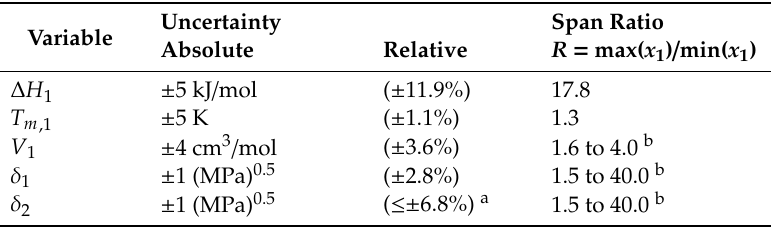
Table 5. Influence of variable uncertainty on molar solubility x 1 of l -ascorbic acid at 25 ◦ C. Uncertainty Span Ratio Variable Absolute Relative R = max( x 1 ) / min( x 1 ) ∆ H ± 5 kJ / mol ( ± 11.9%) 17.8 1 T m ,1 ± 5 K ( ± 1.1%) 1.3 V 1 ± 4 cm 3 / mol ( ± 3.6%) 1.6 to 4.0 b δ ± 1 (MPa) 0.5 ( ± 2.8%) 1.5 to 40.0 b 1 δ ± 1 (MPa) 0.5 ( ≤± 6.8%) a 1.5 to 40.0 2